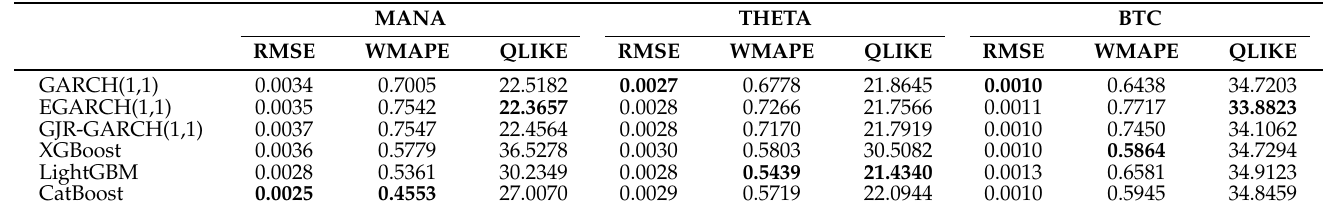
Figure 4. Volatility forecasts. Table 6. Volatility forecast